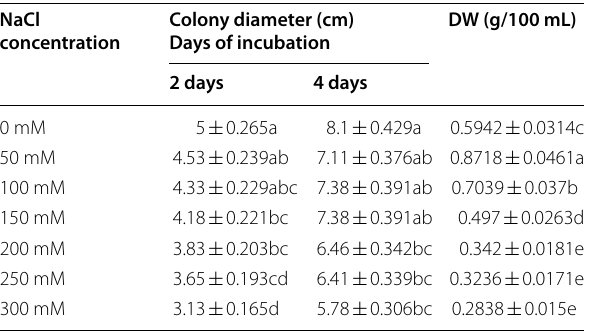
* Data are mean of 5 replicates standard error; the dry weight was determined ± 5 days after inoculation Different letters in the same column mean significant difference at the p < 0.05 level by Duncan’s new multiple range test